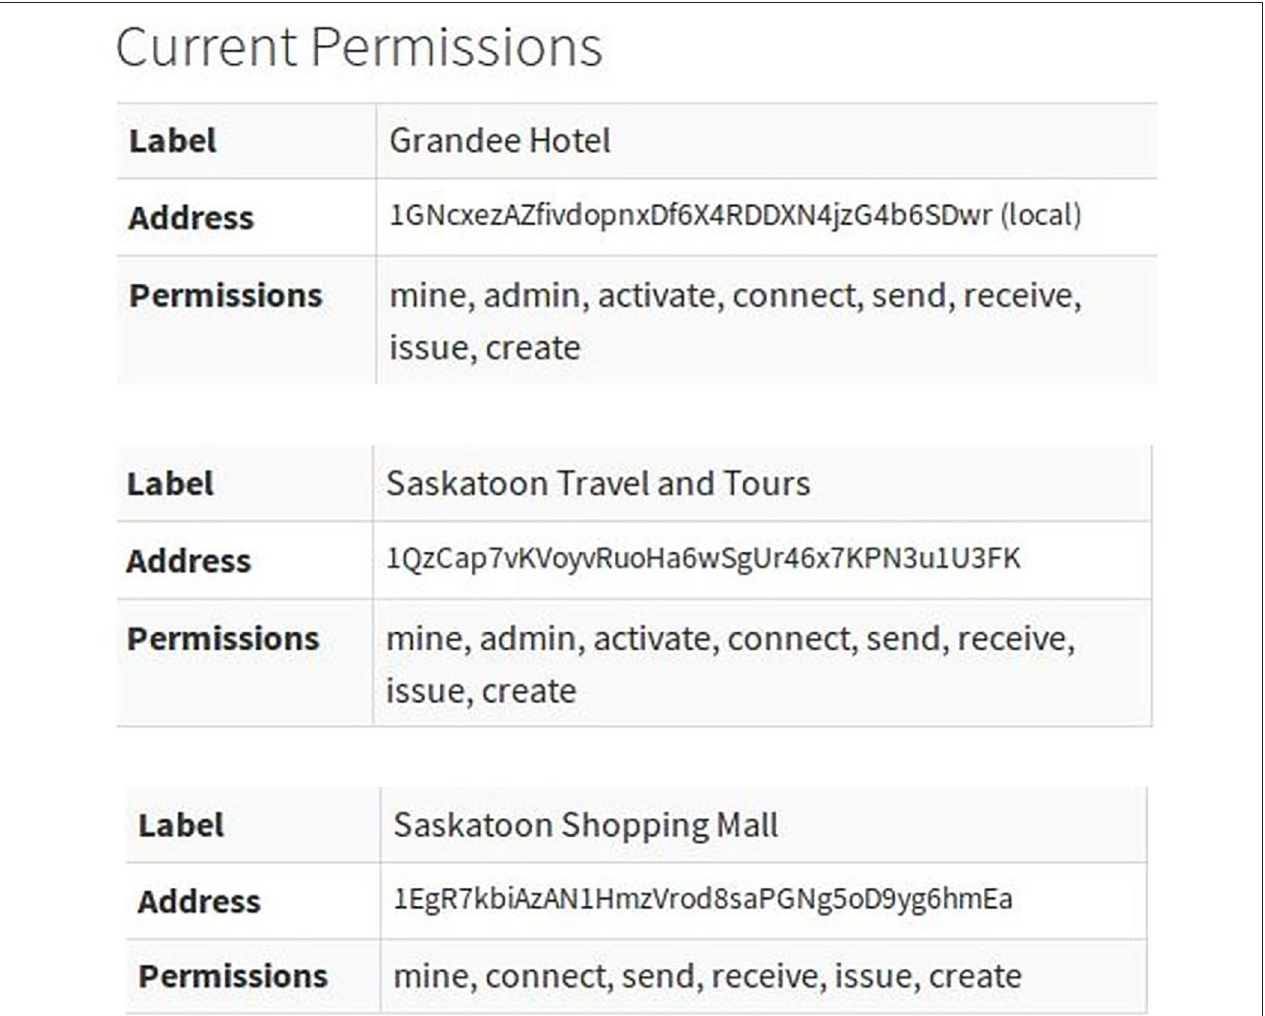
FIGURE 4 | Permissions set for connected nodes as seen from Hotel Reservation System (Node